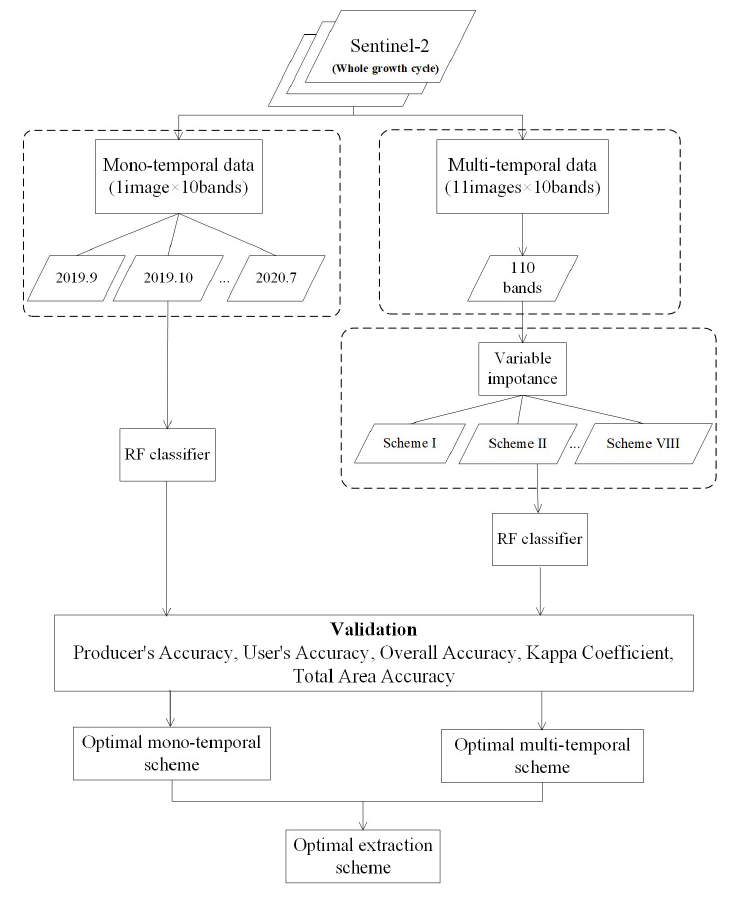
Figure 2. The workflow of optimum extraction scheme.